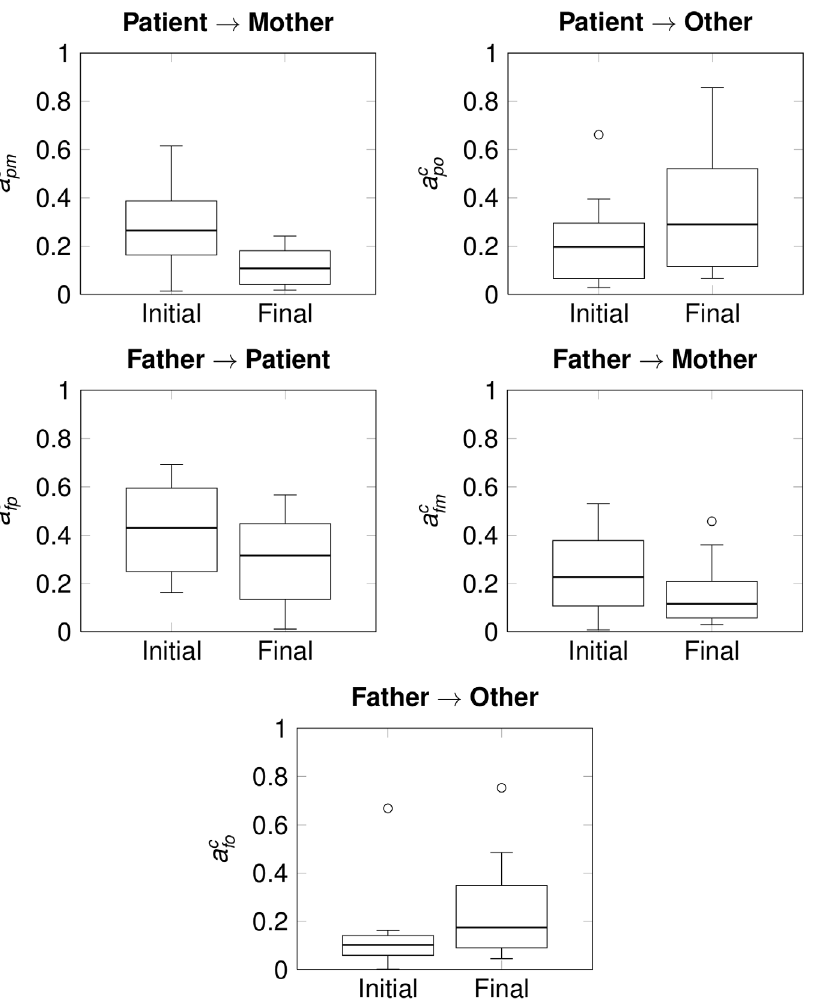
Figure 3. Significant changes between initial and final session of BSFT in affiliative nonverbal behaviour for AN patients and fathers in conflictual situations. Affiliative nonverbal behaviour is measured by eyes contact: a k